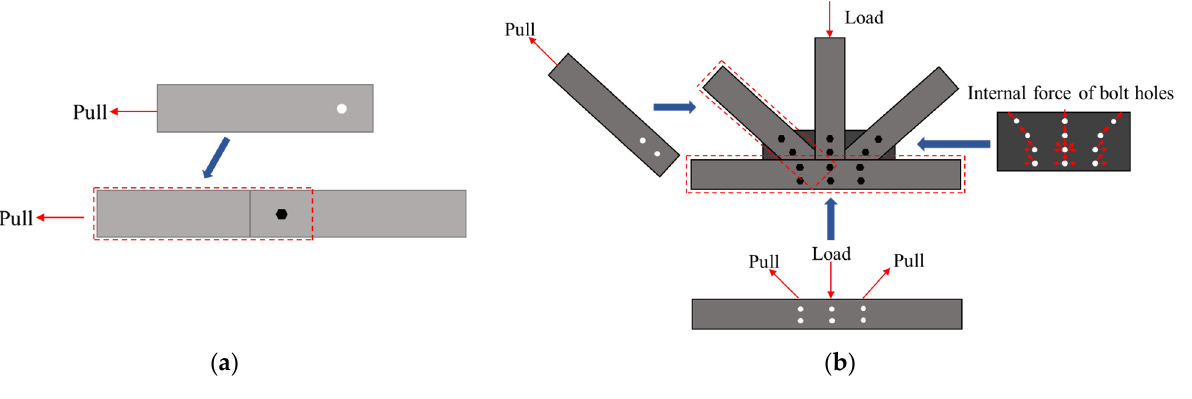
Figure 20. Failure modes of GFRP truss joints: ( a ) double-lap shear test, and ( b ) full-scale GFRP joint test .